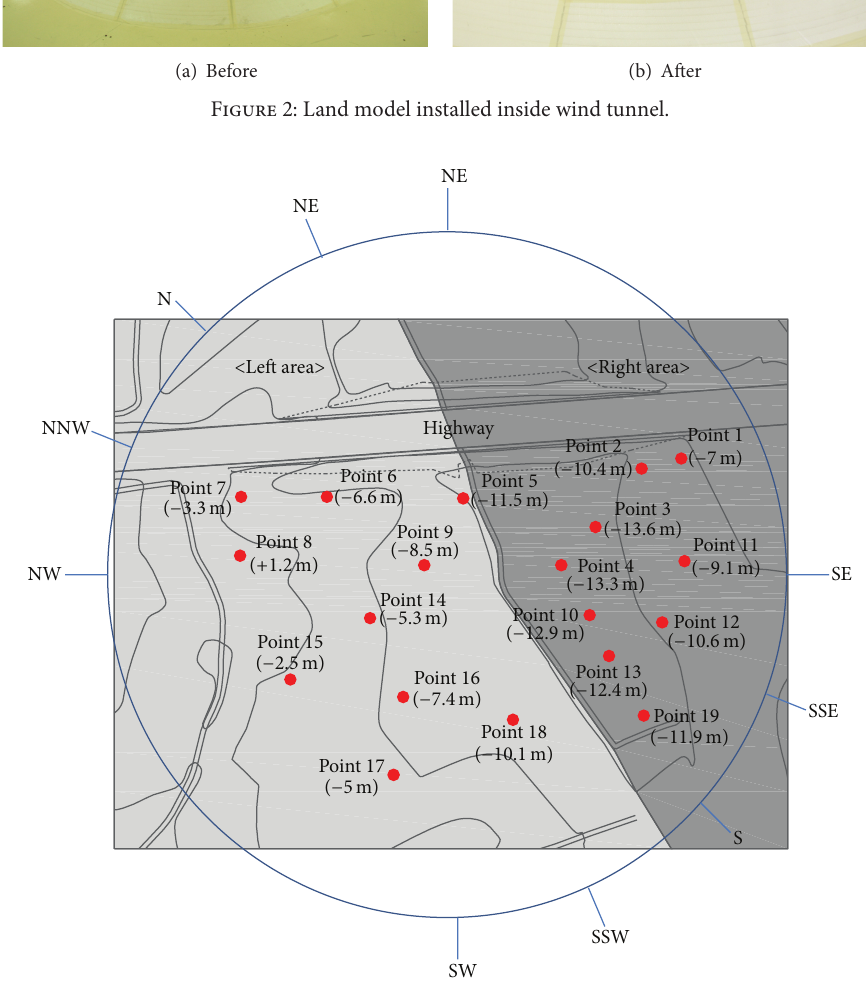
Figure 3: Wind angles and measurement